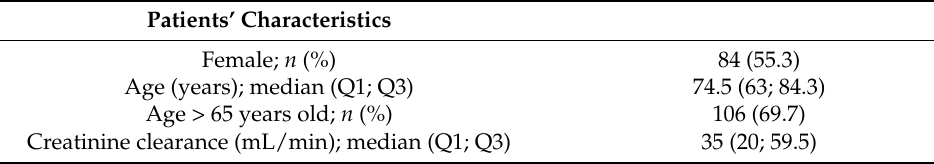
Table 1. Demographic and clinical characteristics of